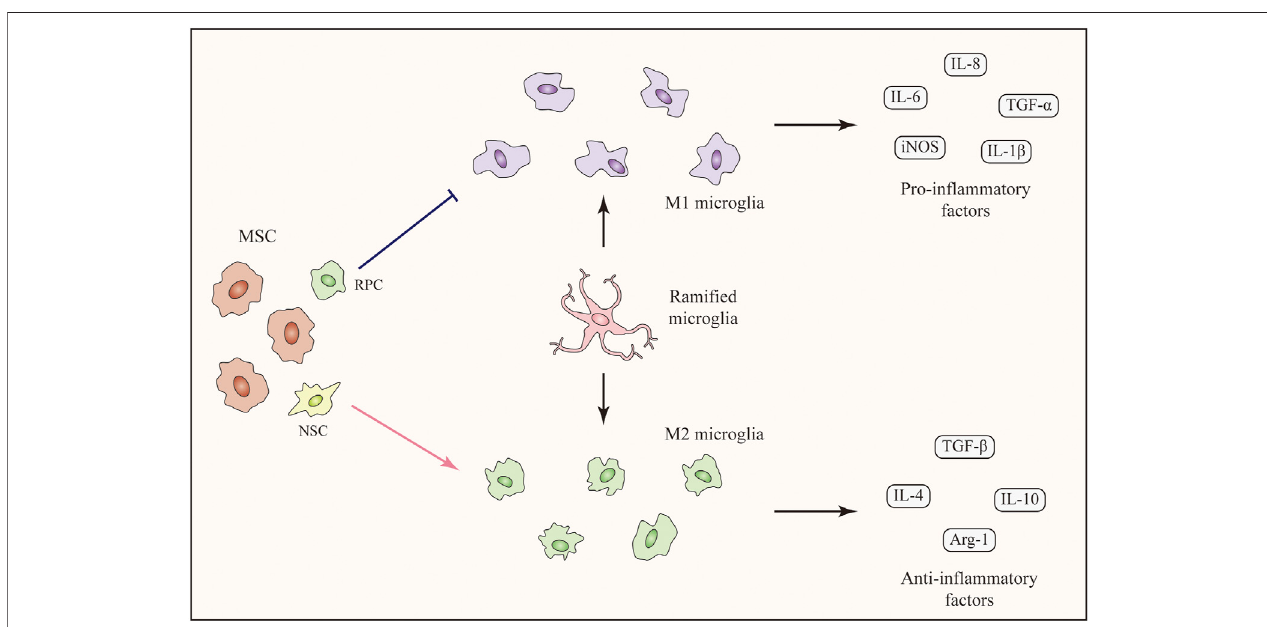
FIGURE 2 | Immunomodulatory effects of SCT targeting microglia. Rami fi ed microglia can be activated with two phenotypes, namely M1 phenotype and M2 phenotype. Stem cells including MSCs, RPCs, and NSCs can modulate microglial polarization (M1-M2), among which MSCs are the major force. MSCs inhibit M1 microglialpolarizationanddecreasetheexpressionlevelofpro-in fl ammatoryfactors.Onthecontrary,M2microglialpolarizationisenhancedandtheexpressionlevelsof anti-in fl ammatory factors are increased. The transition of microglial phenotype alleviates the in fl ammation and improves the living-conditions of neuronal cells.